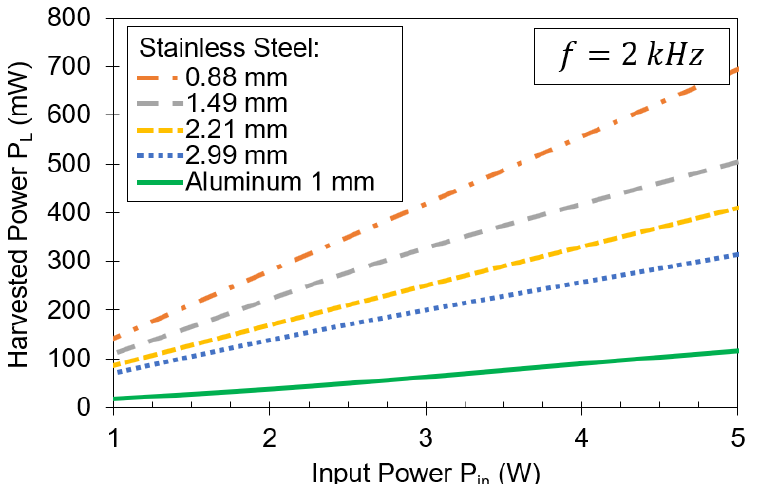
Figure 9. Harvested power versus input power using stainless steel plates of different thickness. Operating frequency is 2 kHz.